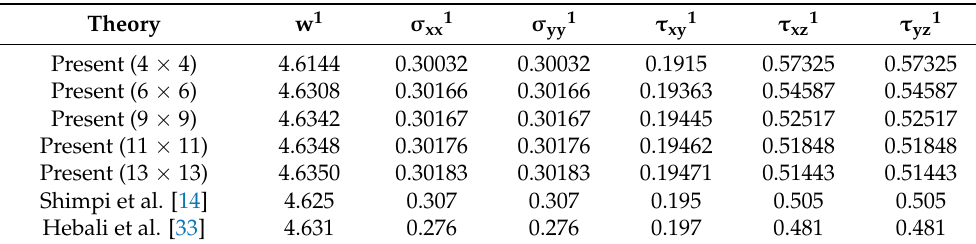
Table 3. Non-dimensional central deflection and stresses in a homogeneous isotropic square plate subjected to the uniformly distributed load. Theory w 1 σ xx1 σ yy1 τ xy1 τ xz1